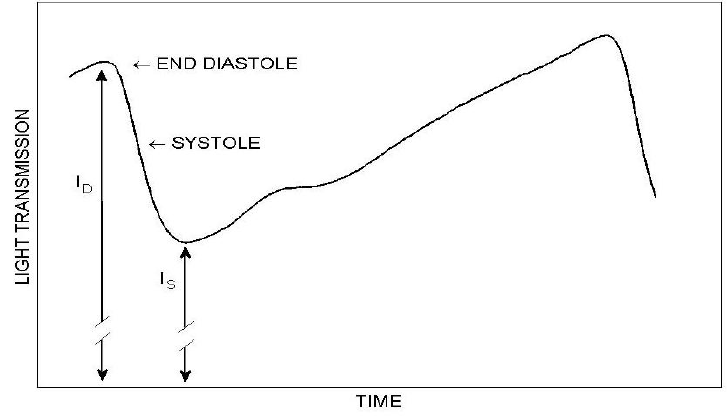
Figure 2. The PPG pulse. The transmitted light through the tissue decreases during systole and increases during diastole. I transmission through the